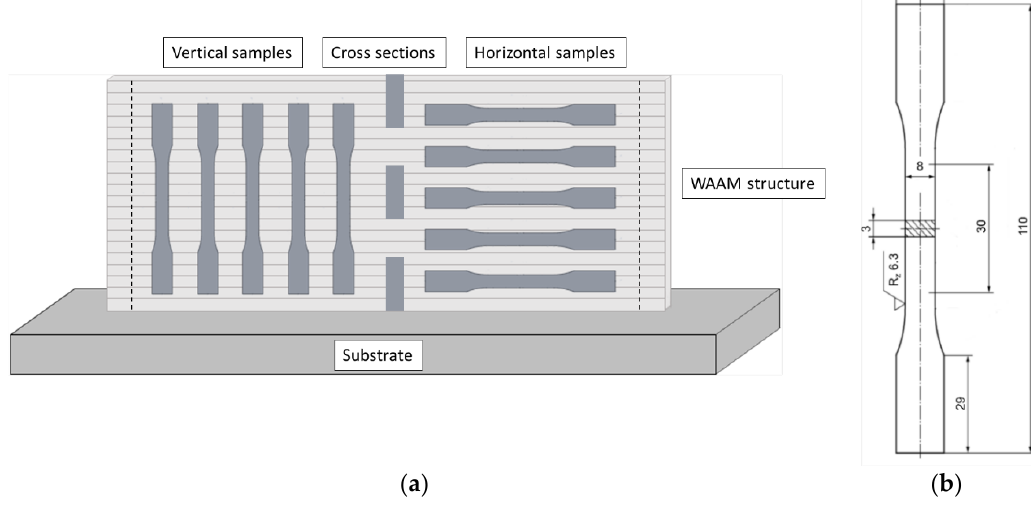
Figure 2. Schematic representation of sample extraction ( a ) and dimensions of tensile samples according to DIN 50125 ( b ).